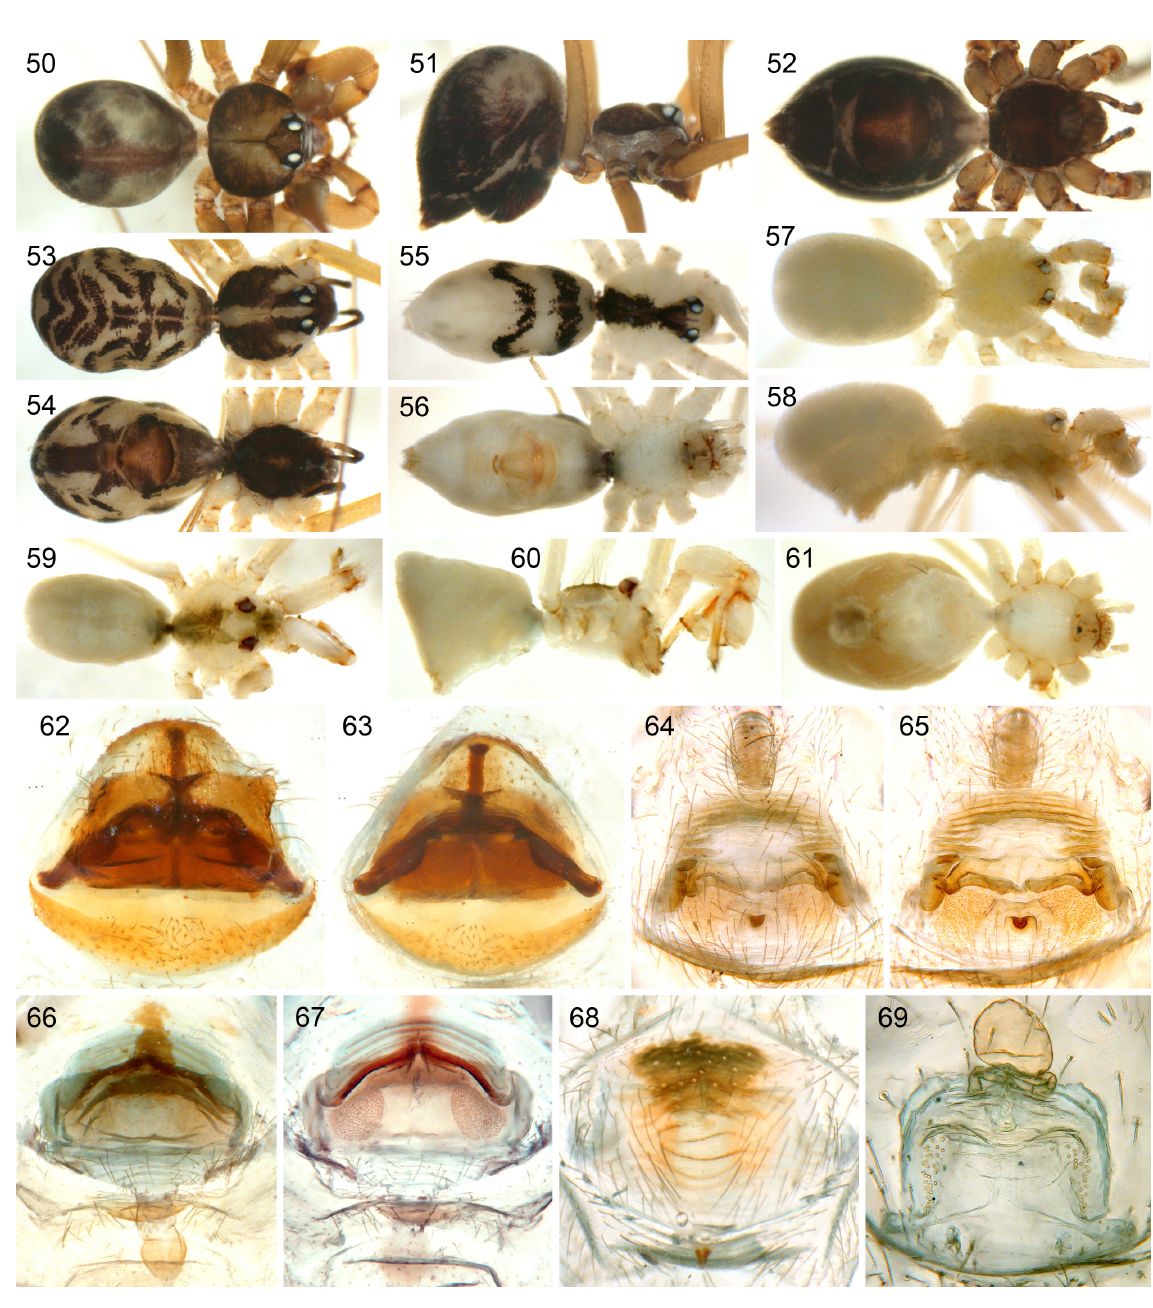
Figs 50-69. — 50-52 . Spermophora kirinyaga sp. nov., ♂ (50) and ♀ (51, 52). — 53-56 . Spermophora minotaura Berland, 1920, ♀♀, dark morph (53, 54) and light morph (55, 56). — 57-58 . Spermophora kyambura sp. nov., ♂. — 59-61 . Quamtana nyahururu sp. nov., ♂ (59, 60) and ♀ (61). — 62-63 . Crossopriza johncloudsleyi Deeleman-Reinhold & van Harten, 2001, cleared ♀ genitalia, ventral and dorsal views. — 64-65 . Buitinga batwa sp. nov., cleared ♀ genitalia, ventral and dorsal views. — 66-67 . Spermophora maathaiae sp. nov., cleared ♀ genitalia, ventral and dorsal views. — 68 . Spermophora bukusu sp. nov., cleared ♀ genitalia, ventral view. — 69 . Spermophora kyambura sp. nov., cleared ♀ genitalia, dorsal